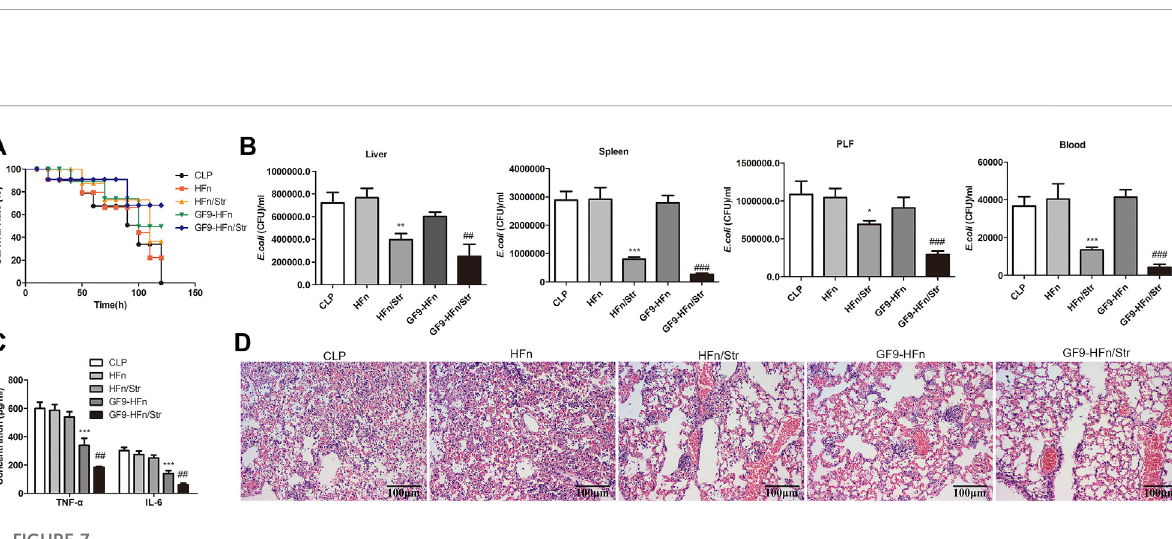
FIGURE 7 GF9 and streptomycin co-delivery nanomedicine relieve E. coli -induced sepsis. (A) The overall survival of mice was calculated. (B) The levels of E. coli in nanomedicines were measured in different tissues in vivo . (C) The levels of TNF- α and IL-6 were assessed in vivo . (D) The Hematoxylin and eosin (H&E) staining evaluated the lung damage of sepsis by nanomedicines. * p < 0.01, ** p < 0.01, *** p < 0.001 vs . CLP. ## p < 0.01, *** p < 0.001 vs .